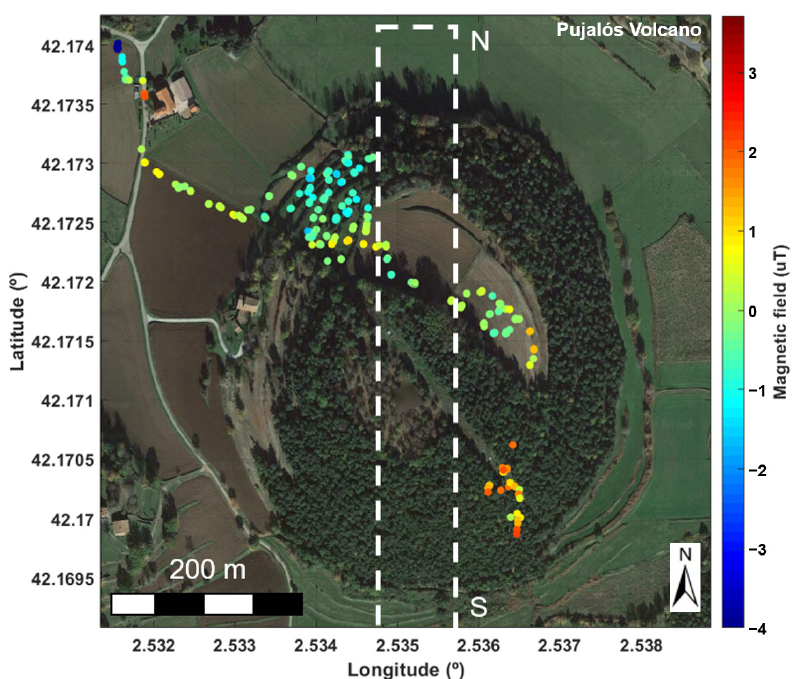
Figure 7. Magnetic anomaly of the Pujalós volcano measured with the on-ground equipment. The rectangle in the dashed lines shows the transect for the modeling.